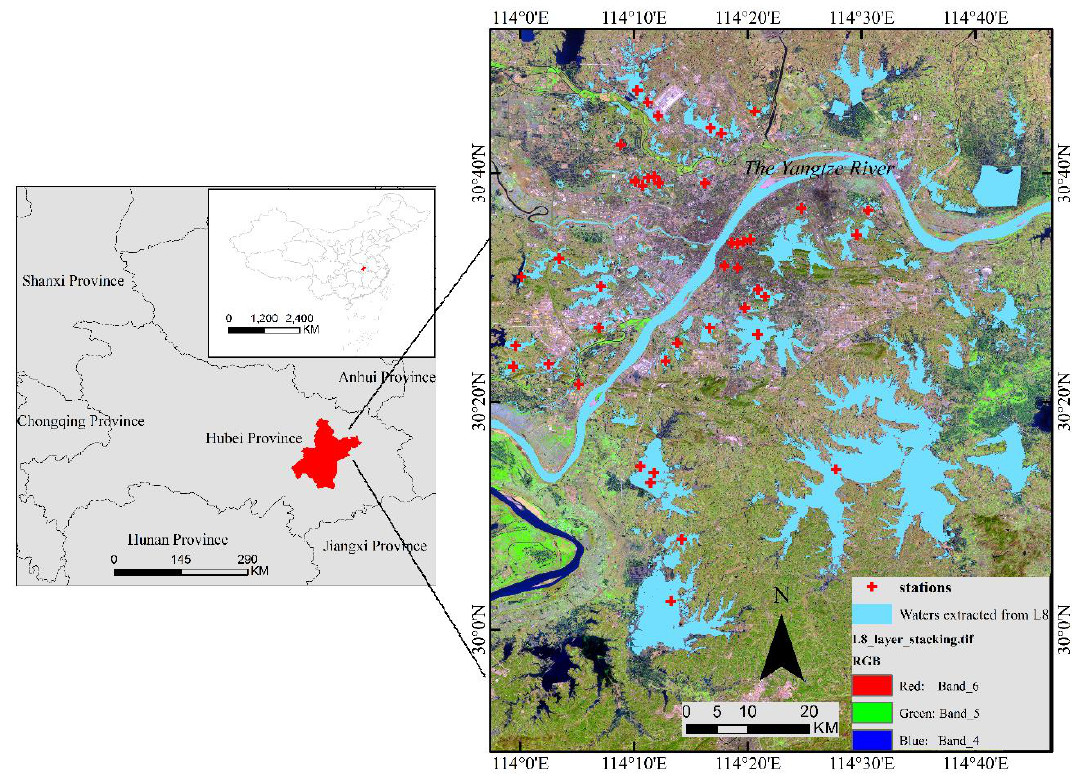
Figure 1. Study area and stations.